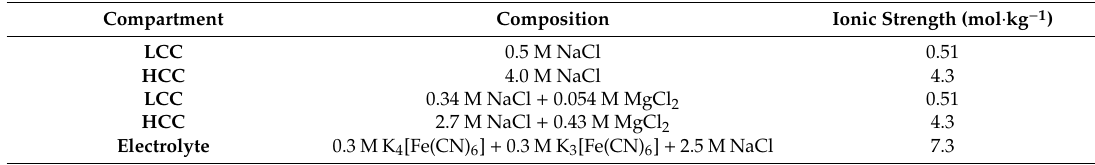
Table 1. Concentration and ionic strength of feed and electrolyte solutions used in RED.